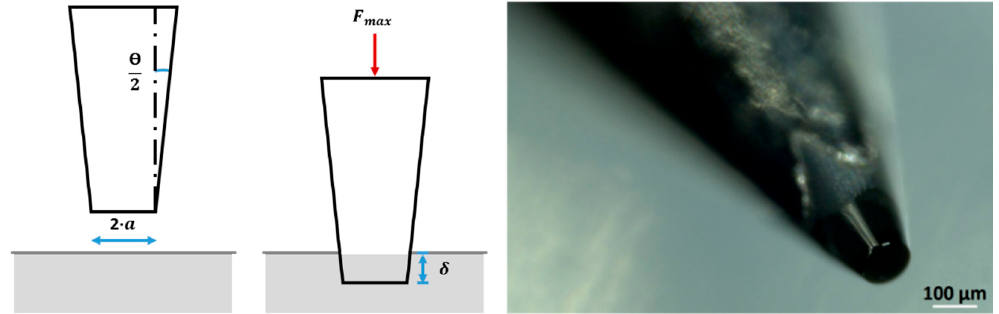
Figure 1. ( Left ) Schematic view of indentation with a frustum-shaped indenter with an opening angle θ = 40 ◦ and a punch radius a = 50 µ m. F max corresponds to the maximum indentation force and δ , the indentation depth at this force; ( Right ) Microscope acquisition of the 100 µm flat punch.